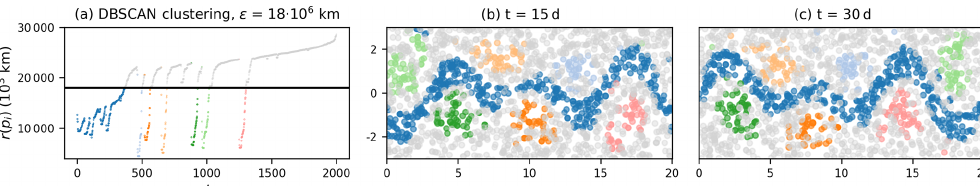
Figure A2. Result of the OPTICS algorithm for a random subset of 2000 particles in the Bickley jet flow, with particle data every 5d instead of every day. To account for the smaller number of particles, we set s min = 15 for this case. The six vortices and the jet are still clearly